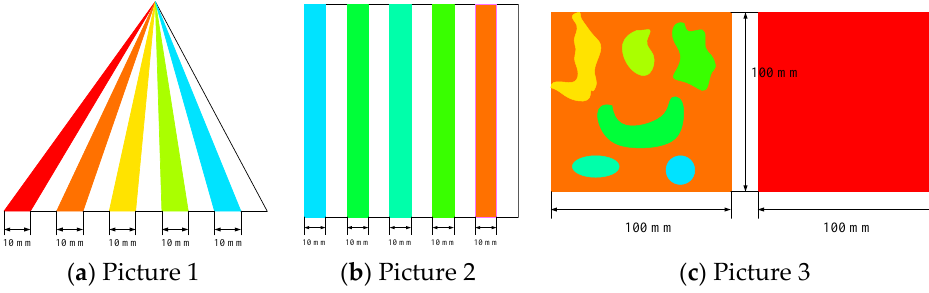
Figure 8. The verification pictures of damage statistics software.